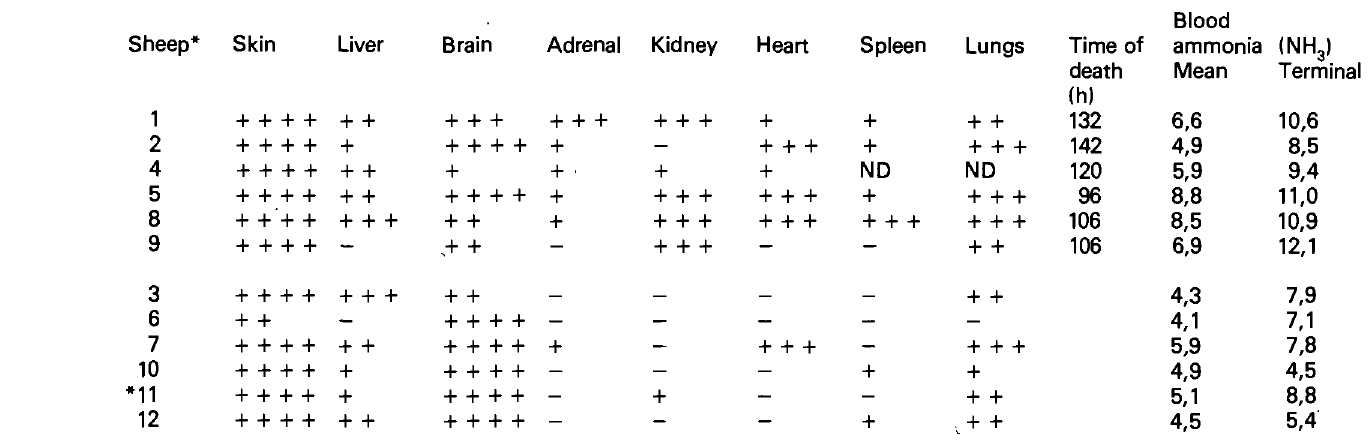
(J.lmoll- 1) in sheep infested by Lucilia cuprina larvae